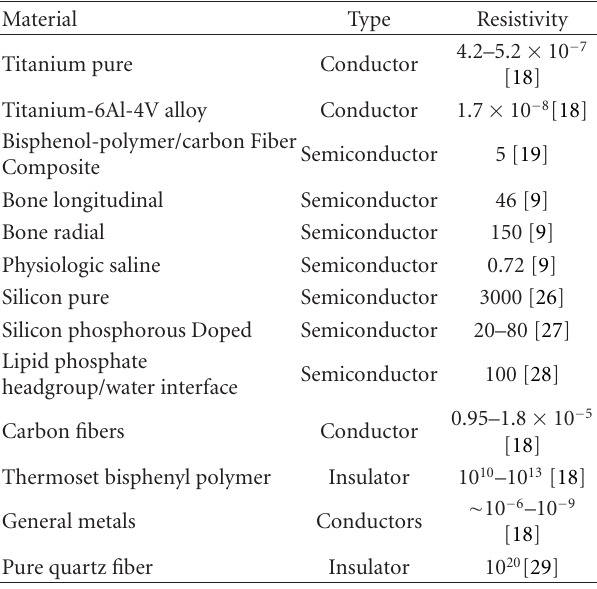
Table 2: Resistivity a of di ff erent engineering and biological materi- als ( Ω